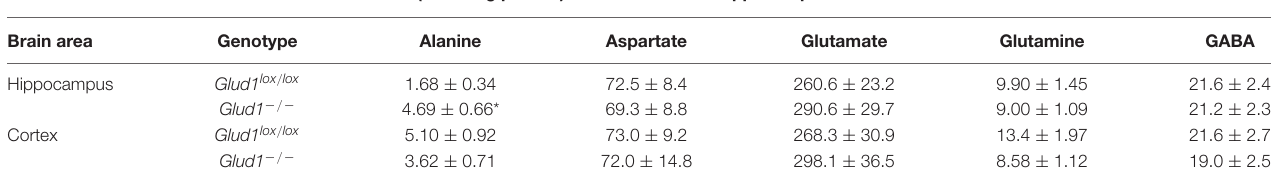
The results are presented as averages ± SEM based on measurement of slices from 9 to 10 individual mice. Statistically significant differences (P < 0.05) between Glud1 lox / lox and CNS-Glud1 − / − mice are indicated with an asterisk.